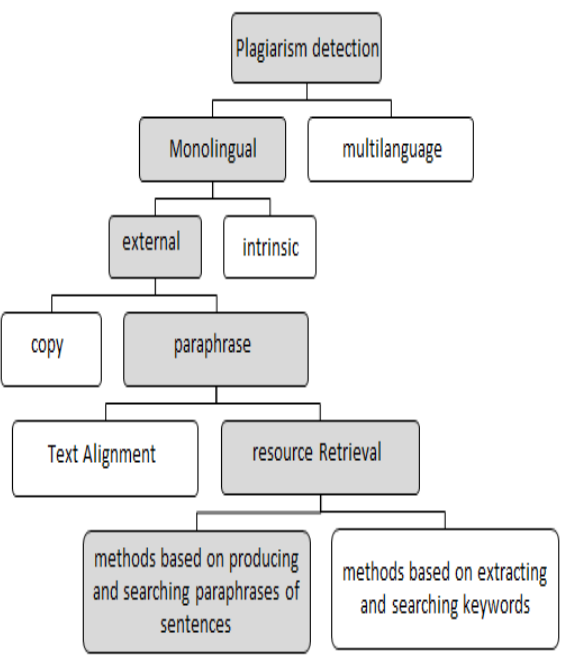
Figure 1. Taxonomy of plagiarism detection